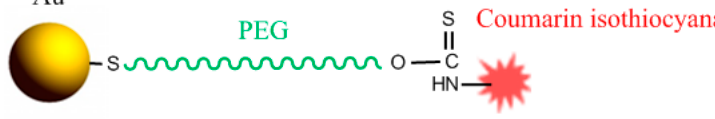
Figure 7. Chemical connectivity of Coumarin-PEG-Au nanoparticle design.